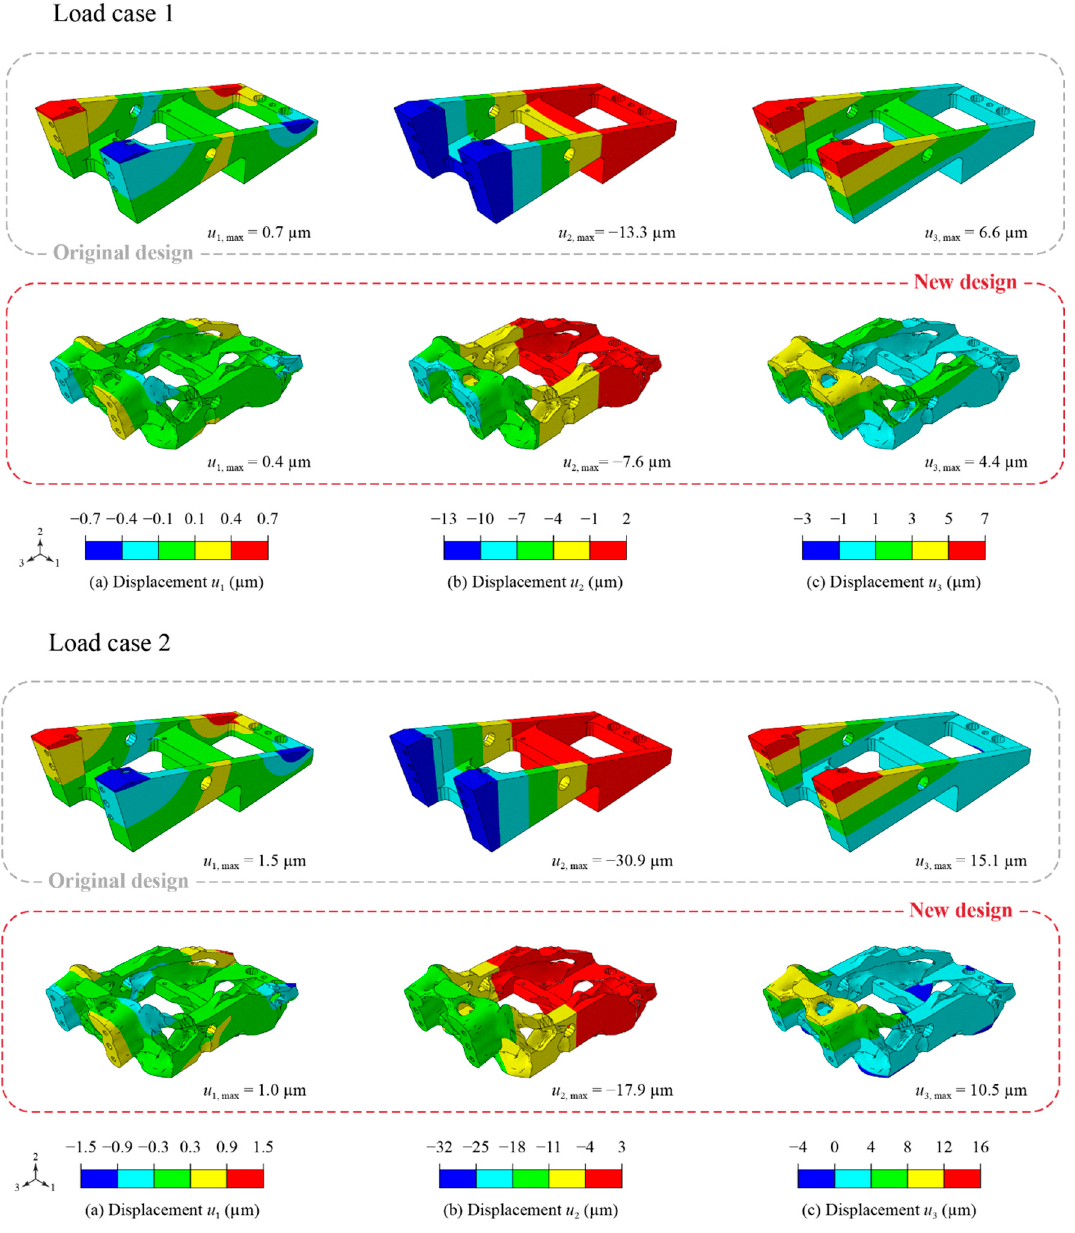
Figure 10. Comparison of the original and new designs for load case 1 (the bracket is subjected to its own weight and to that of vision and lighting systems and a probe) and load case 2 (the probe tests a MEMS). The lower displacements in the case of the new design demonstrated an overall increasing of the stiffness of the bracket. Table 2. Process parameter values employed for the bracket production.